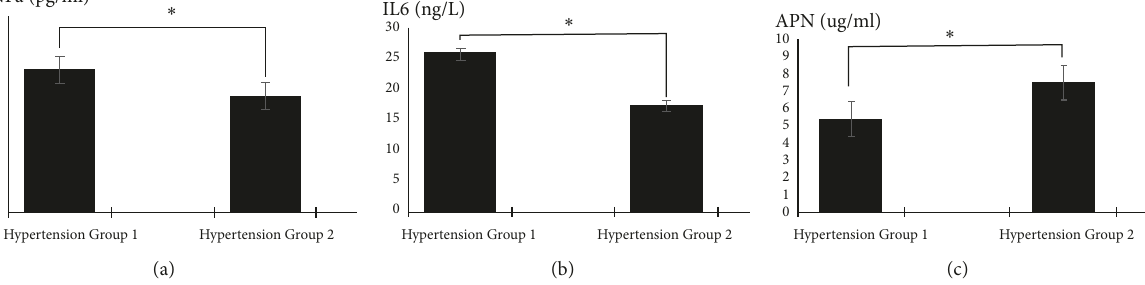
Figure 2: (a) Comparison of TNF- 𝛼 concentration between group 1 and group 2. ∗ P < 0.05. (b) Comparison of IL-6 concentration between group 1 and group 2. ∗ P < 0.05. (c) Comparison of APN concentration between group 1 and group 2. ∗ P < 0.05.